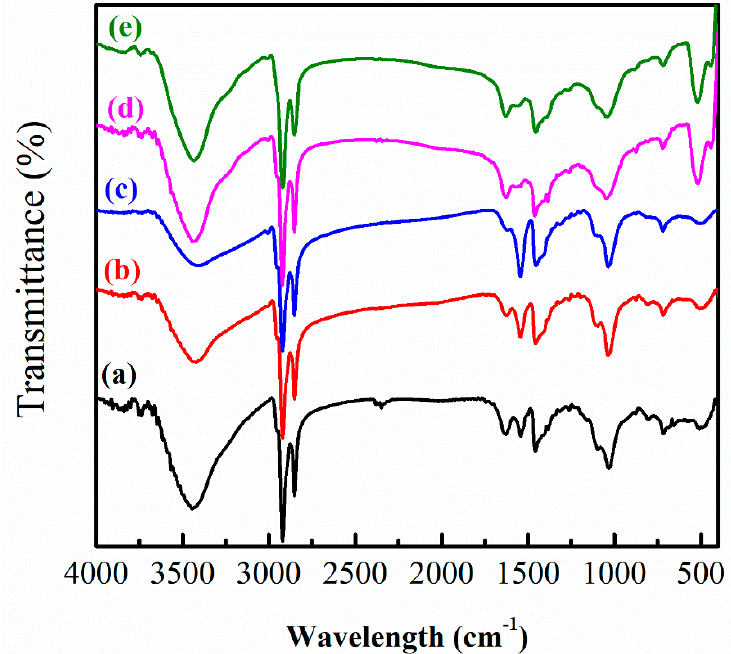
Figure 5. FTIR spectra showing the influence of the various OLA content on ( a ) pure Zn 0.5 Cd 0.5 Se, ( b ) Zn 0.5 Cd 0.5 Se-2, ( c ) Zn 0.5 Cd 0.5 Se-4, ( d ) Zn 0.5 Cd 0.5 Se-6, and ( e ) Zn 0.5 Cd 0.5 Se-10 alloy QDs.